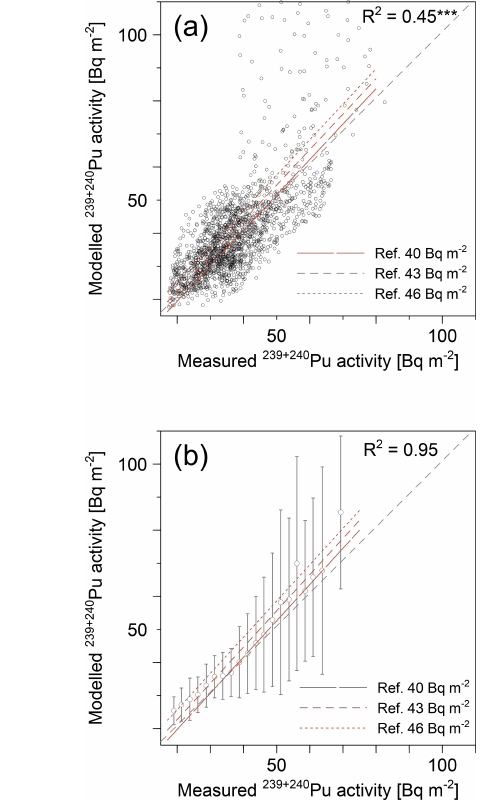
Figure 5. Linear correlation between measured and modelled 239 + 240 Pu inventories redistributed by water ( k tc : 150, P fac- tor: 1) and tillage erosion ( k til : 350kgm − 1 ; ∗ = p value < 0 . 001). (a) Point-by-point correlation at 5m × 5m resolution ( n : 1699); (b) class aggregation according to 239 + 240 Pu-derived soil redis- tribution. Minimum and maximum class n is 27 and 184, respec- tively. While the points and classes are calculated for a reference of 43Bqm − 2 , the trend lines display the offset sensitivity of different reference 239 + 240 Pu activities.